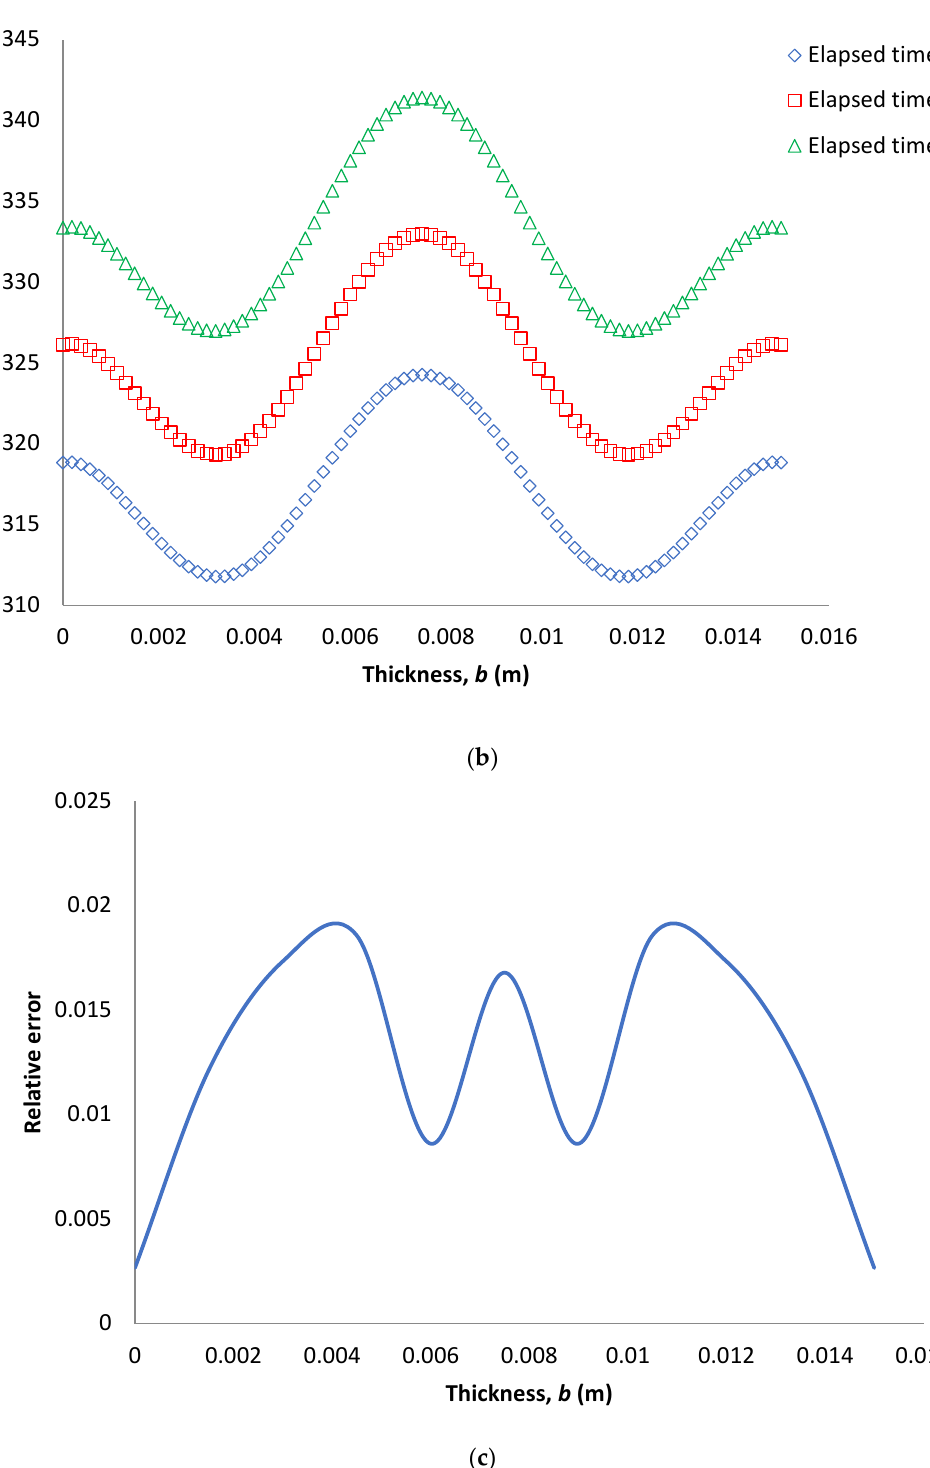
Figure 2. Verification of finite element (FE) simulation: ( a ) results of temperature profiles along the axial center of cylindrical beef with respect to the variation of microwave heating times; ( b ) results of temperature profiles along the axial center of salmon slab with respect to the variation of microwave heating times; ( c ) relative errors between temperatures along the axial center of salmon slab obtained from FE simulation and the analytical solution.